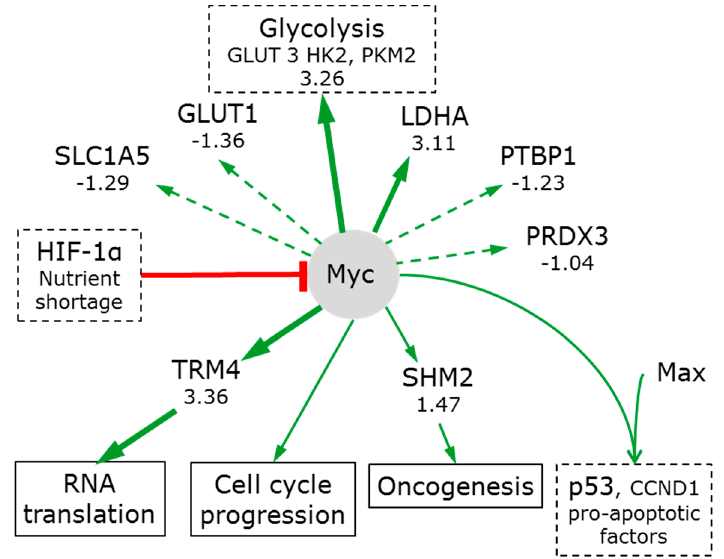
Figure 7. Myc signalling in 3D spheroids. See legend to Figure 4 for nomenclature.